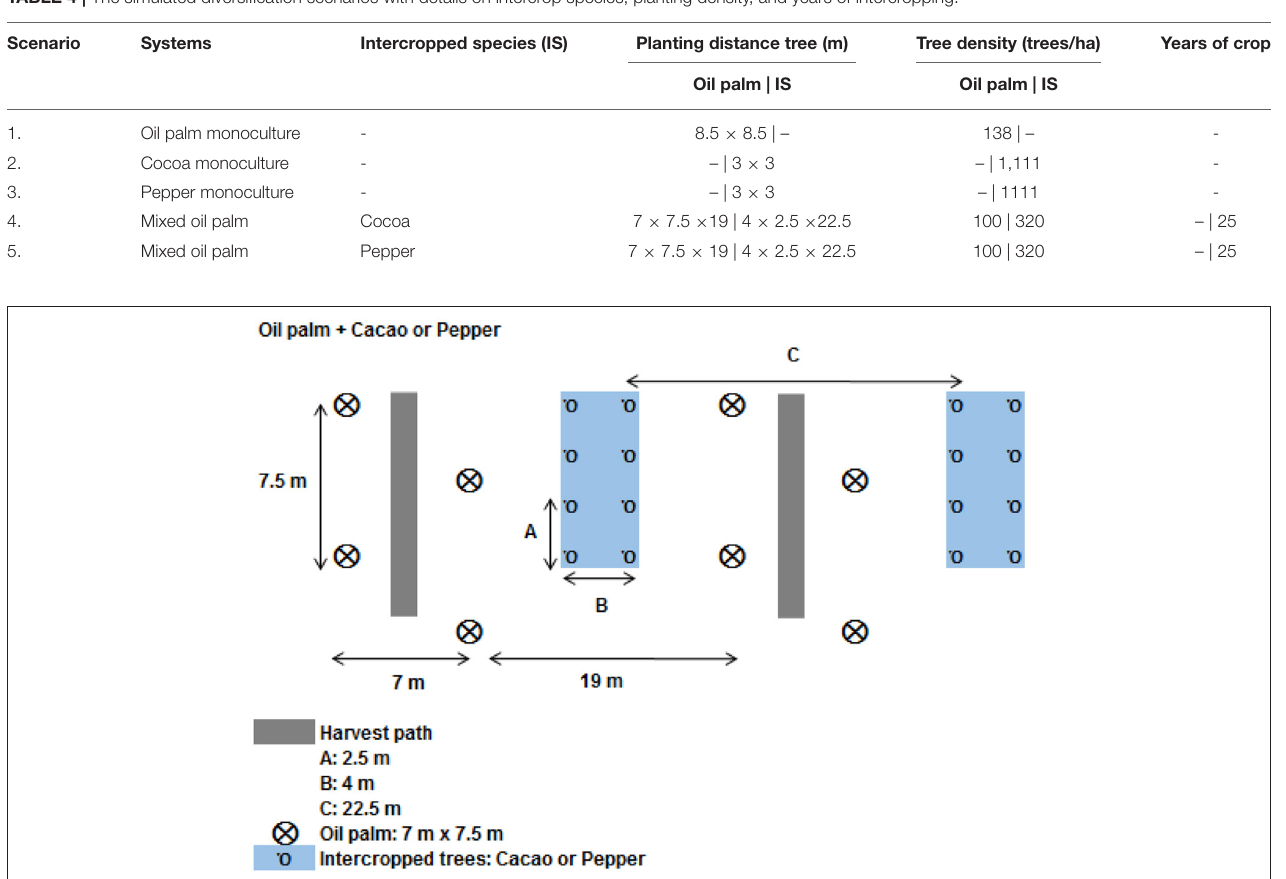
We used results for three functions: (1). Time-averaged C stock in tC ha − 1 , (2). Water use (recycling to atmosphere) in mm y − 1 , (3). Groundwater recharge, mm y − 1 and two disfunctions, (4). Surface runoff in mm y − 1 , and (5). N losses to ground- and surface water in kg N ha − 1 y − 1